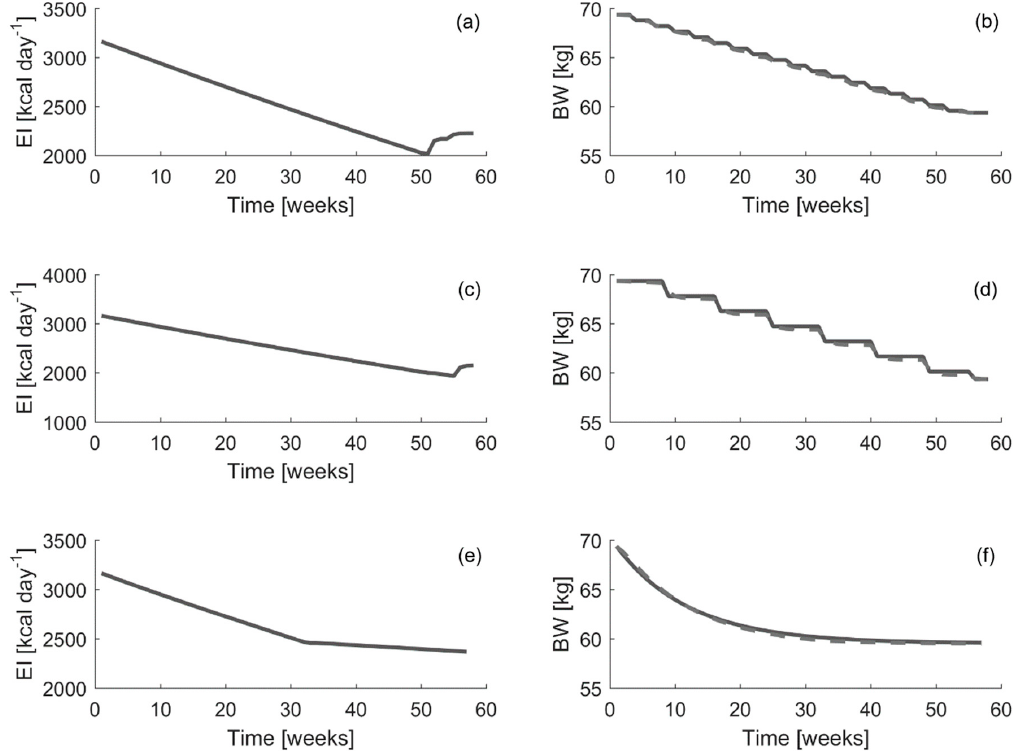
Figure 5. Energy intake curves suggested by the MPC controller using the time-invariant averaged TF model in order to follow the theoretical bodyweight curves 1, 2 and 3, ( a ), ( c ) and ( e ), respectively. The reference bodyweight curves 1, 2 and 3 (solid lines) and bodyweight curves obtained with the MPC simulation (dashed lines) are display in ( b ), ( d ) and ( f ), respectively. Table 8. Normalized root mean square error ( NRMSE ), root mean square error ( RMSE ), in kg, and Pearson correlation coefficient ( r ) for the comparison between the bodyweight curve obtain following the suggestions from the MPC systems using the time-invariant parameters transfer function model, without (TI) and with constraints (TIC) and the three theoretical bodyweight reference curves generated.